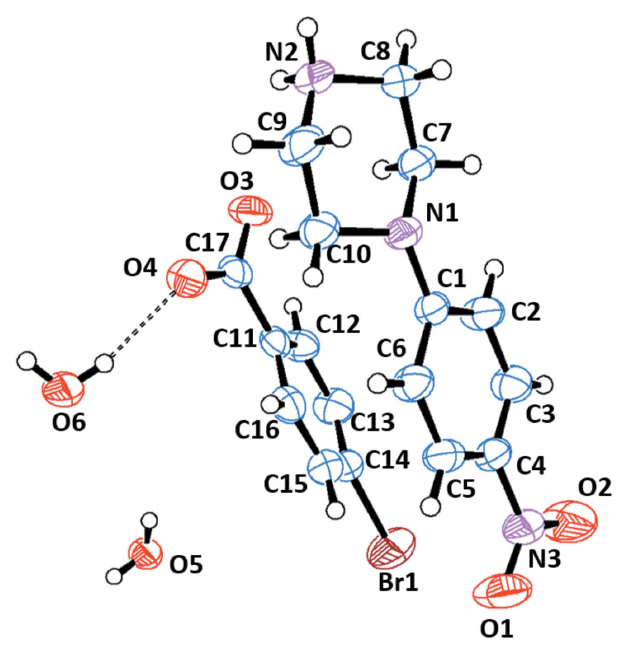
Figure 1 The independent components of compound (I) showing the atom- labelling scheme and the hydrogen bonds, drawn as dashed lines. Displacement ellipsoids are drawn at the 50% probability